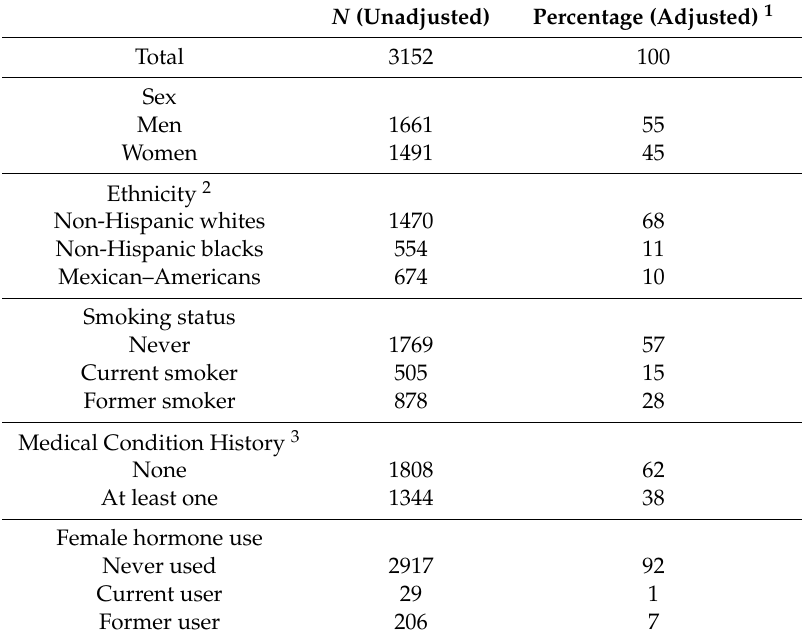
Table 1. Background information of study participants 20 years and older with overweight or obesity as per the National Health and Nutrition Examination Survey (NHANES) of 2009 / 2010.